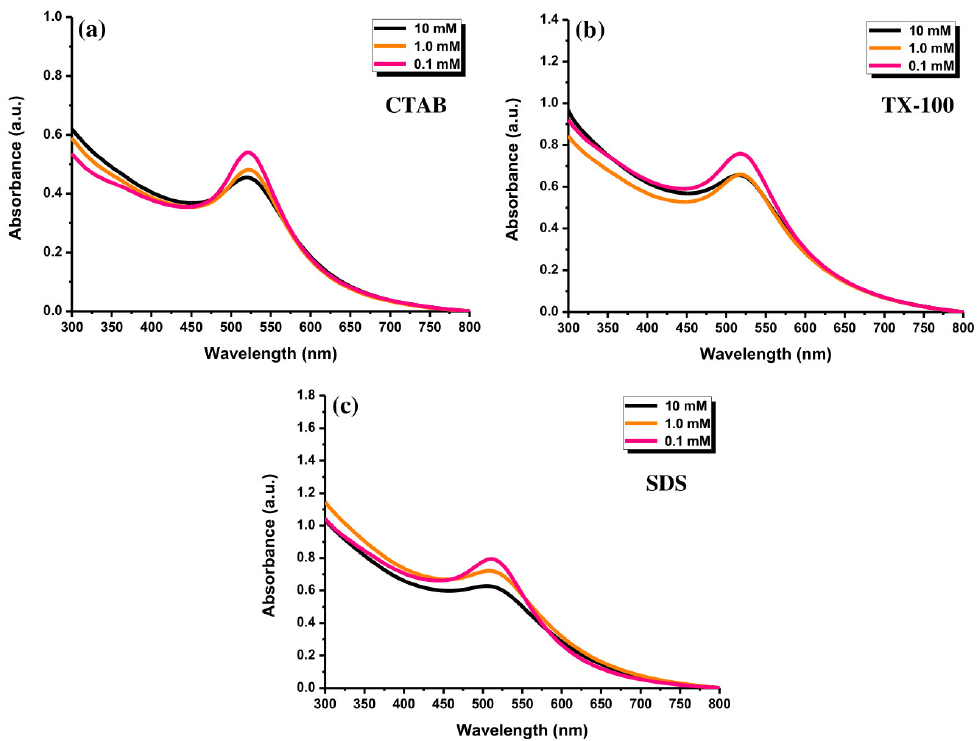
Figure 8. The UV-Vis absorption spectra of Au NPs after ablating for 40 min with ( a ) CTAB, ( b ) TX-100, and ( c ) SDS, at the concentrations of 0.1, 1.0, and 10 mM and laser fluence of 0.4 J cm − 2